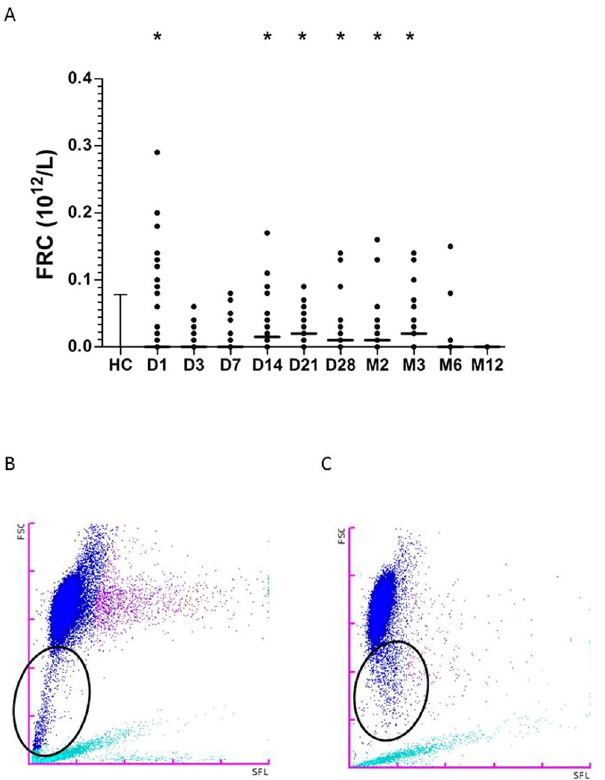
Figure 3. Thermal injury causes red cell lysis resulting in the production of fragmented red cells (FRC). ( A ) FRC across time (n = 39) differences in kinetics were compared to data from control cohort (n = 40) using a Mann-Whitney test; * p < 0.005. ( B ) A representative scatter graph displaying FRC (black circle) detectable on day 1 post injury. ( C ) A representative scatter graph displaying FRC (black circle) detectable on day 13 post injury. The intensity of the forward scatter (FSC, y-axis) indicates the cell volume and the side fluorescence indicates the amount of DNA and RNA present in the cell (SFL, x-axis). Colour key for scatter graphs; light blue = optical platelet count, dark blue = mature red blood cells, purple to orange = reticulocyte